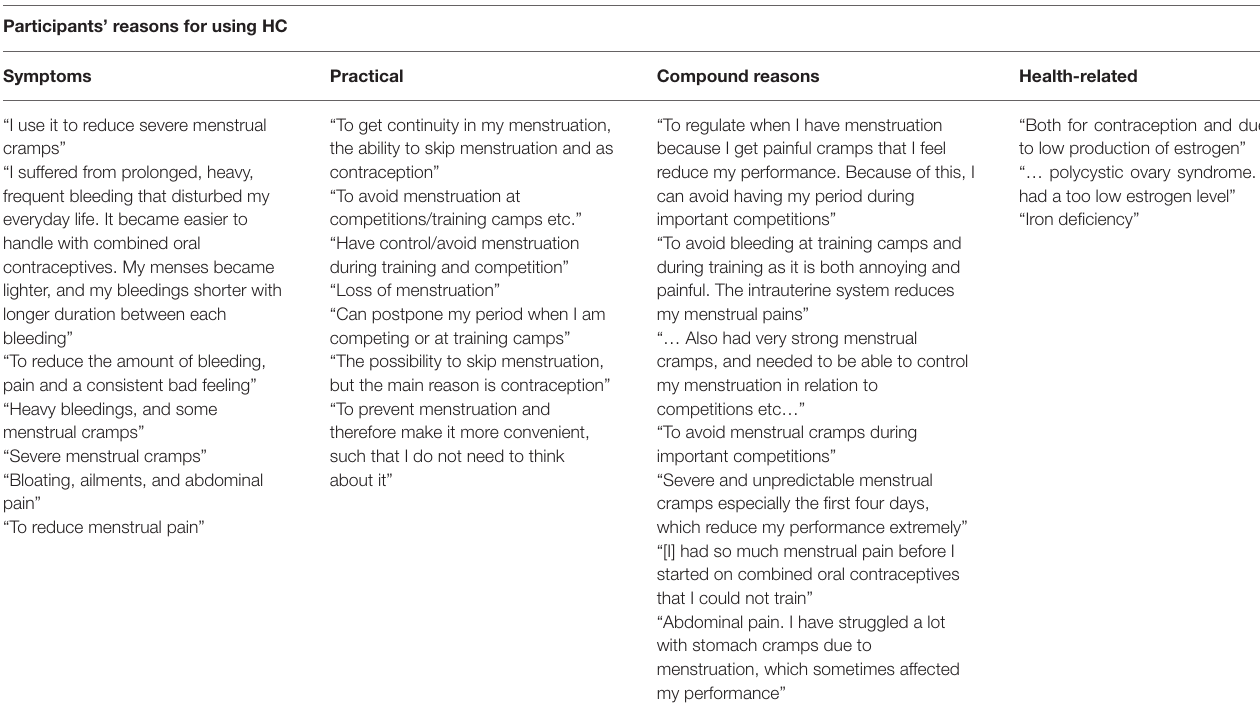
TABLE 3 | Selection of responses: reasons for hormonal contraceptive (HC) use. Participants’ reasons for using